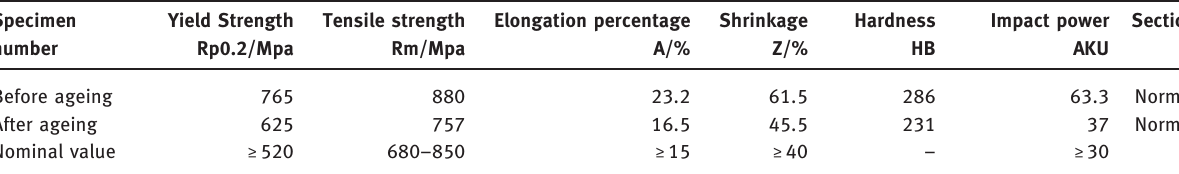
Table 2: Mechanical properties of steel ZG1Cr10MoWVNbN.